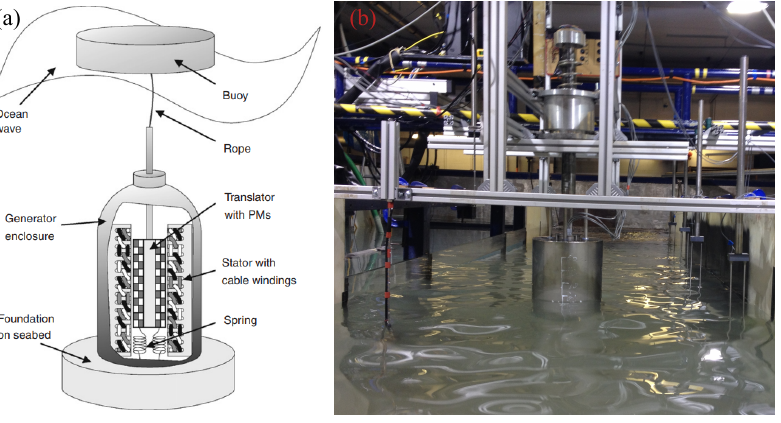
Figure 15. Direct-drive power take-off mechanisms with a schematic plot ( a ) and a heaving point absorber with a linear generator ( b ), adapted from